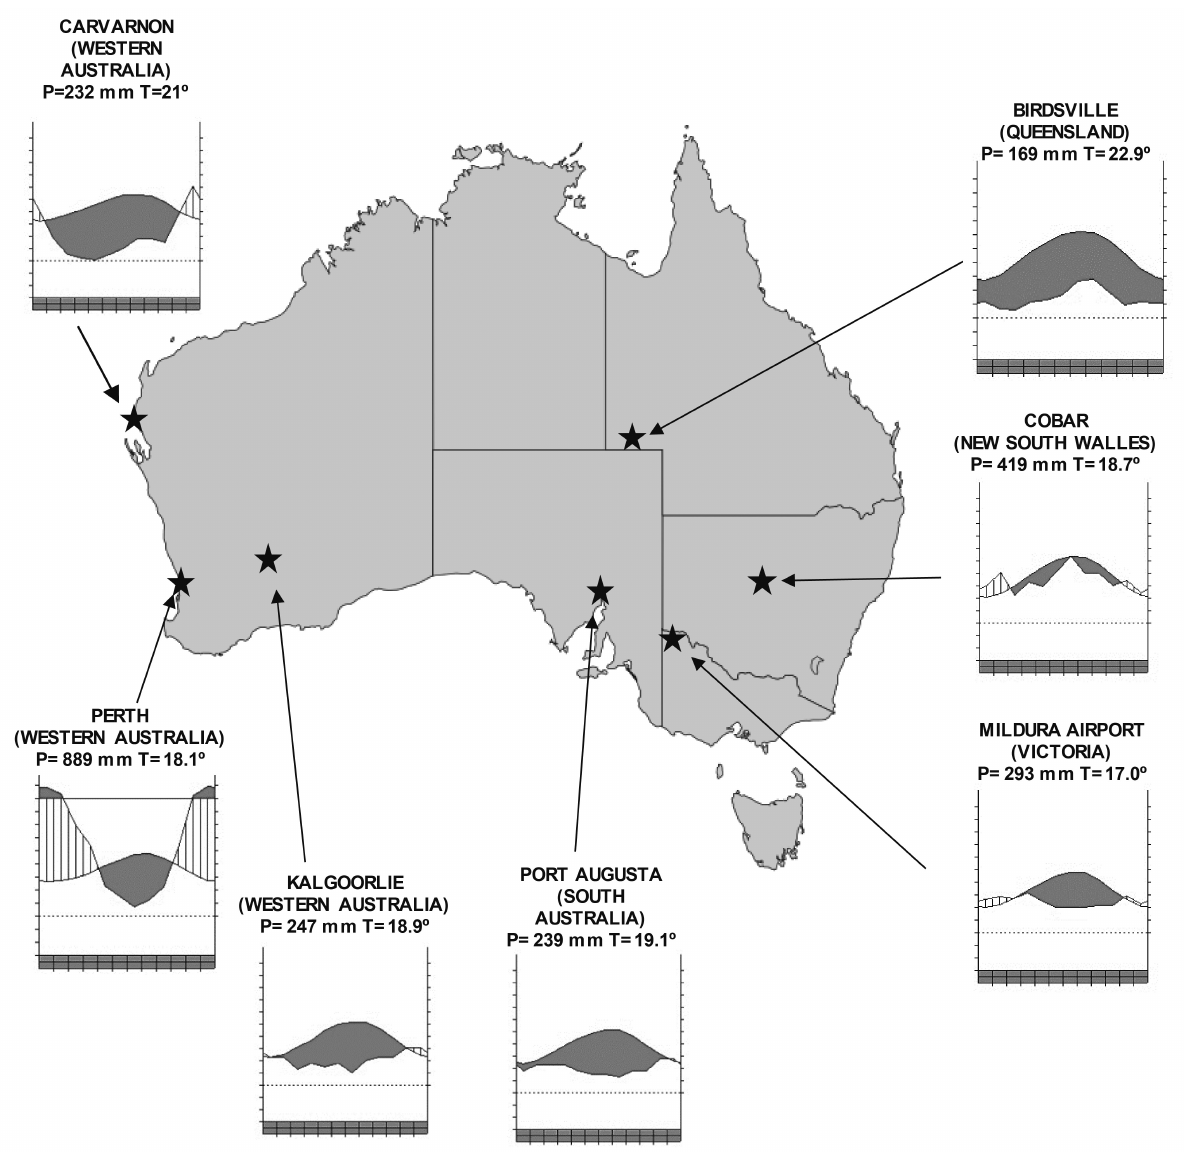
Figure 8. Bioclimatic diagrams of different localities with flora linked to gypsum substrates, from Australia (Retrieved from